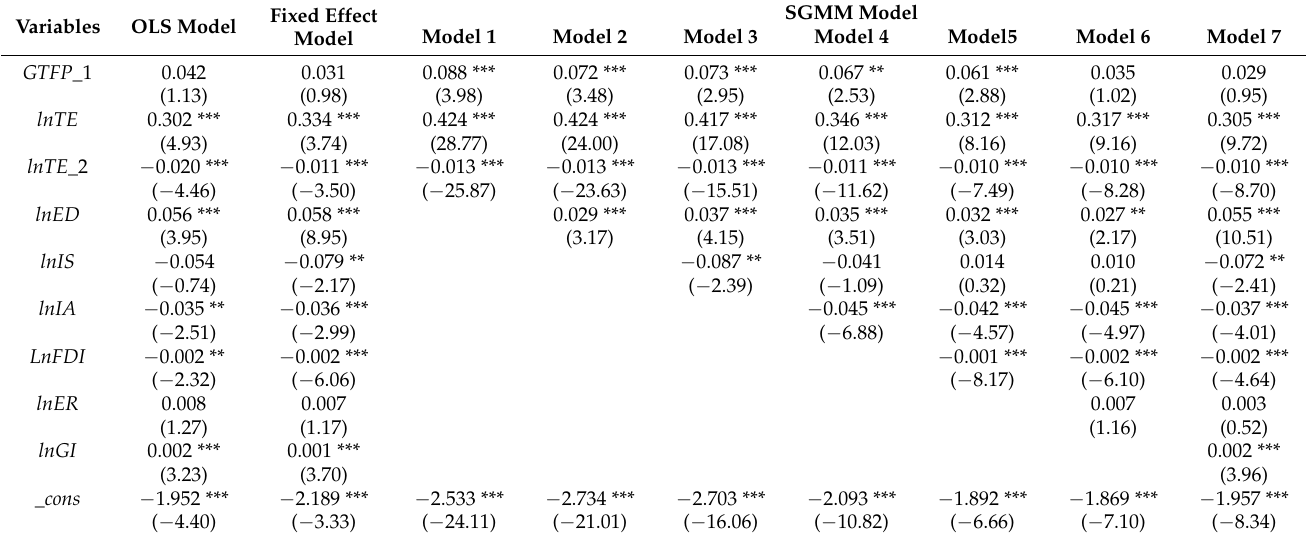
Table 6. Systematic dynamic panel regression results of the factors influencing green development